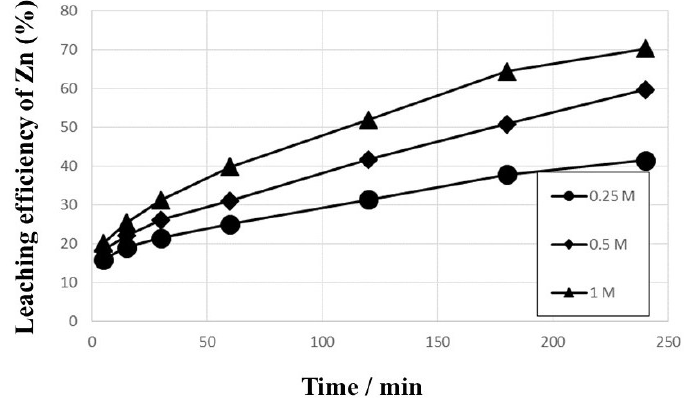
Figure 3. The effects of Fe 3+ concentration on the leaching efficiency of Zn at 1 kmol·m −3 HCl, 10% pulp density, 50 °C, and 400